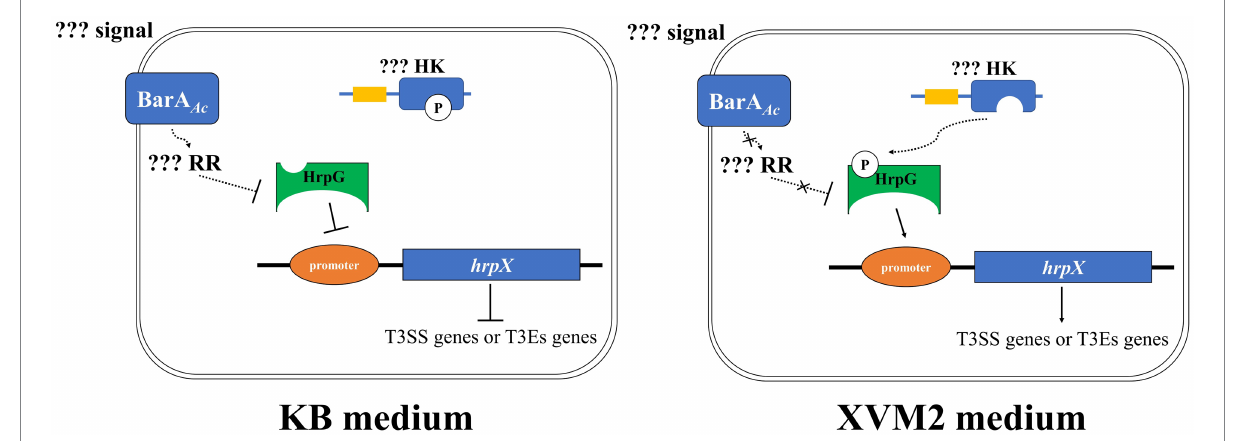
FIGURE 7 The regulation model of BarA Ac in Acidovorax citrulli Aac5 strain. Signal refers to extracellular signal that BarA Ac can perceive and RR refers to response regulator regulated by BarA Ac , respectively. HK refers to the histidine kinase possibly involved in HrpG phosphorylation, and promoter refers to the promoter region of hrpX gene. The solid line indicates direct regulation, the dashed line indicates unknown pathway or indirect regulation, the blunt arrow indicates inhibition, and the pointed arrow indicates activation. In addition, the curve indicates the transfer of the phosphate